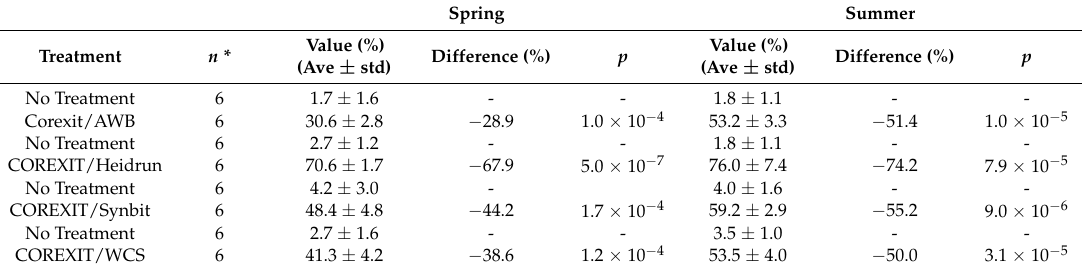
Table 2. Analysis of variance of the randomization tests showing the dispersion effectiveness of dispersant to the natural dispersion of four oils under breaking waves. The value of “ p ” provides information on the probability of the observation (i.e., difference) to be due to randomness. The smaller the value of “ p ” the less likely the difference is due to randomness. Average ± Standard Deviation (Ave ± std). Spring Summer Value (%) Value (%) Difference (%) p Difference (%) p Treatment n * (Ave ± std) (Ave ± std) No